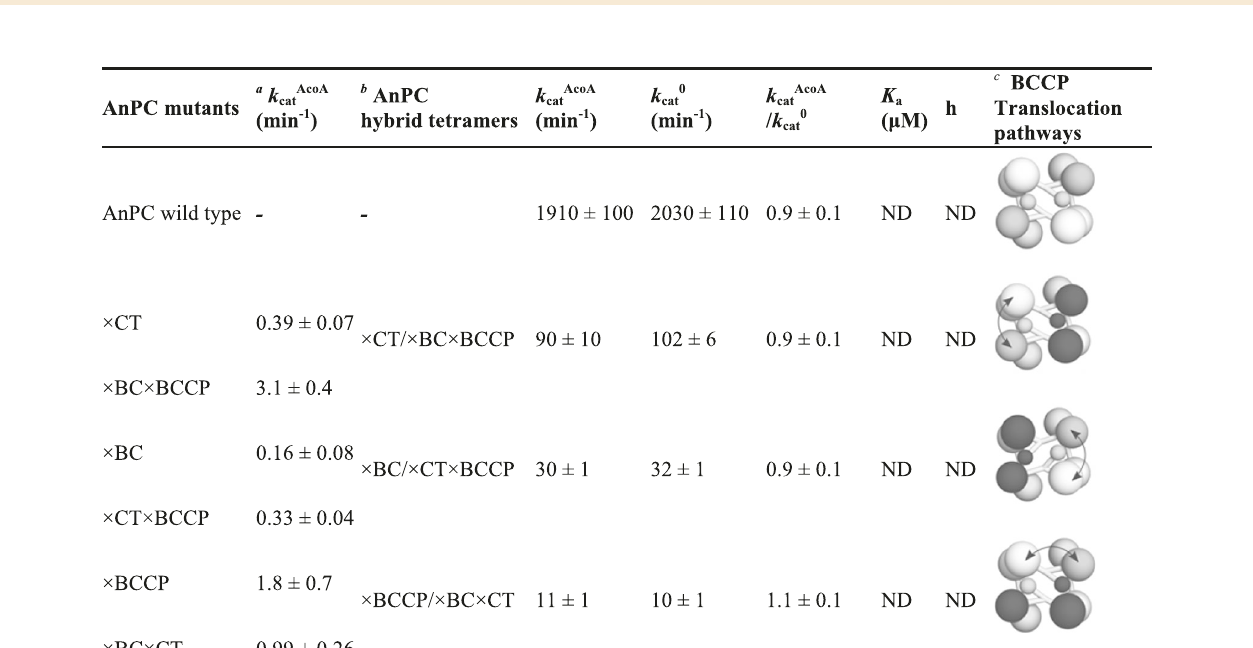
Table 3 Activation by acetyl coenzyme A of wild type and mutated AnPC and hybrid